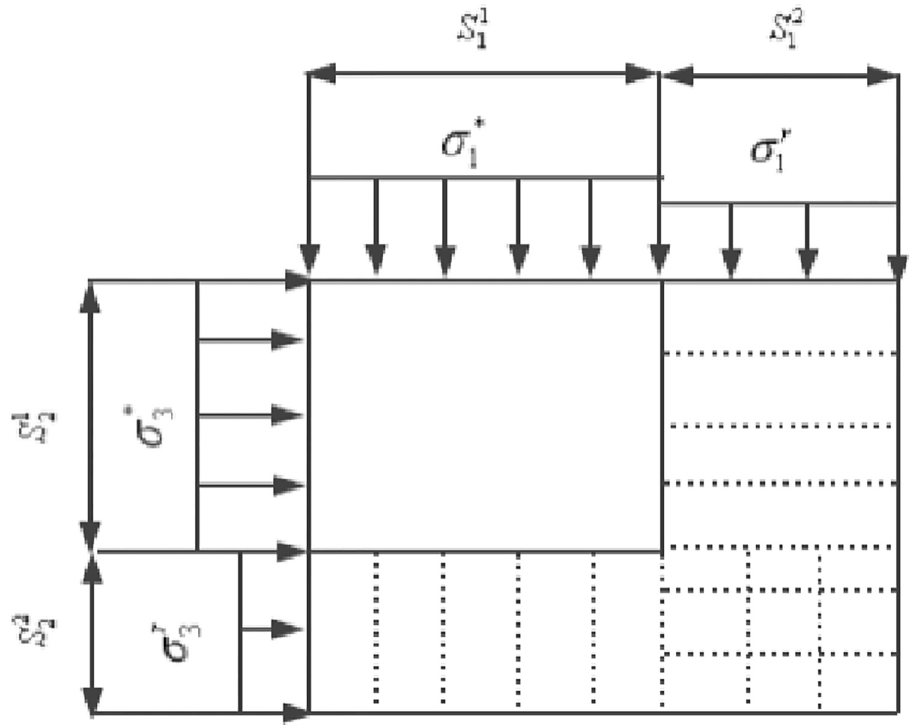
Fig 1. The statistical damage micromechanical